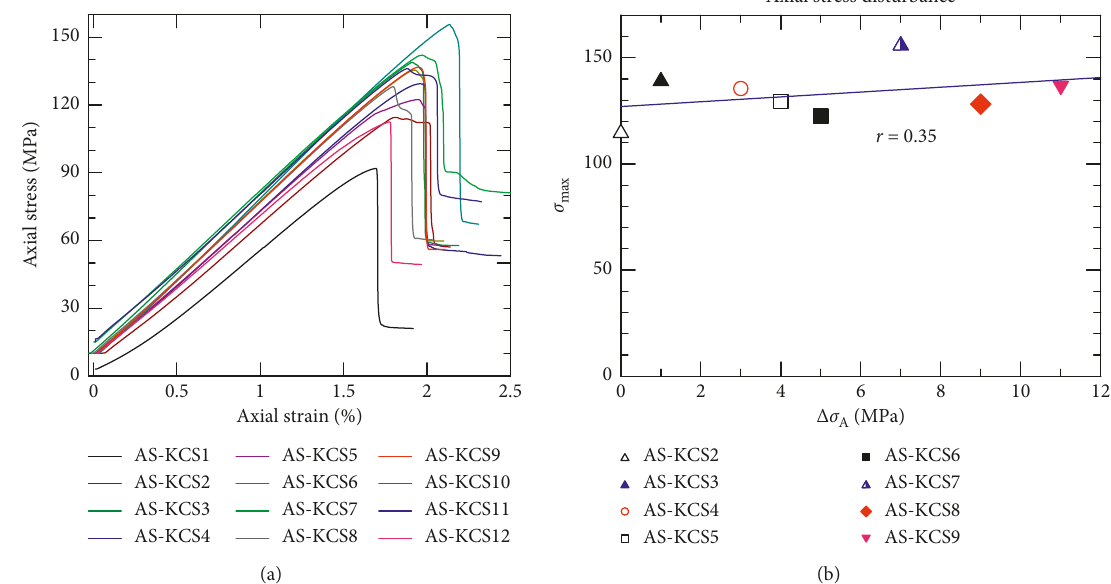
Figure 5: (a) Stress-strain curves and (b) maximum stress ( σ of the Kushiro Cretaceous